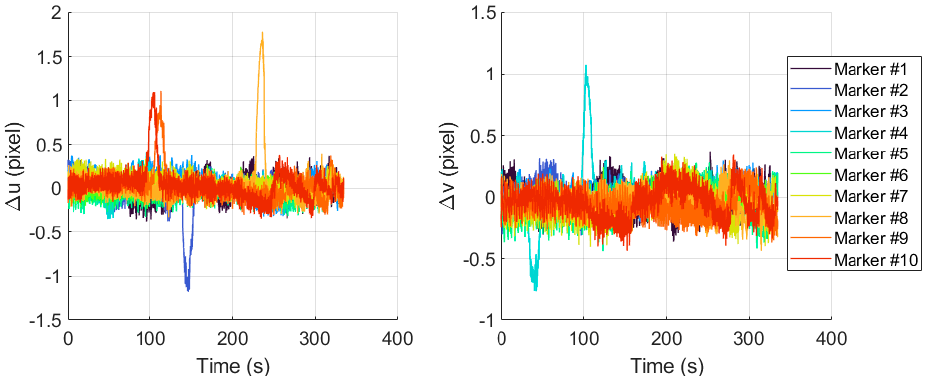
Figure 16. Temporal evolution of the centroiding errors over a single simulation for test cases S7 and I.